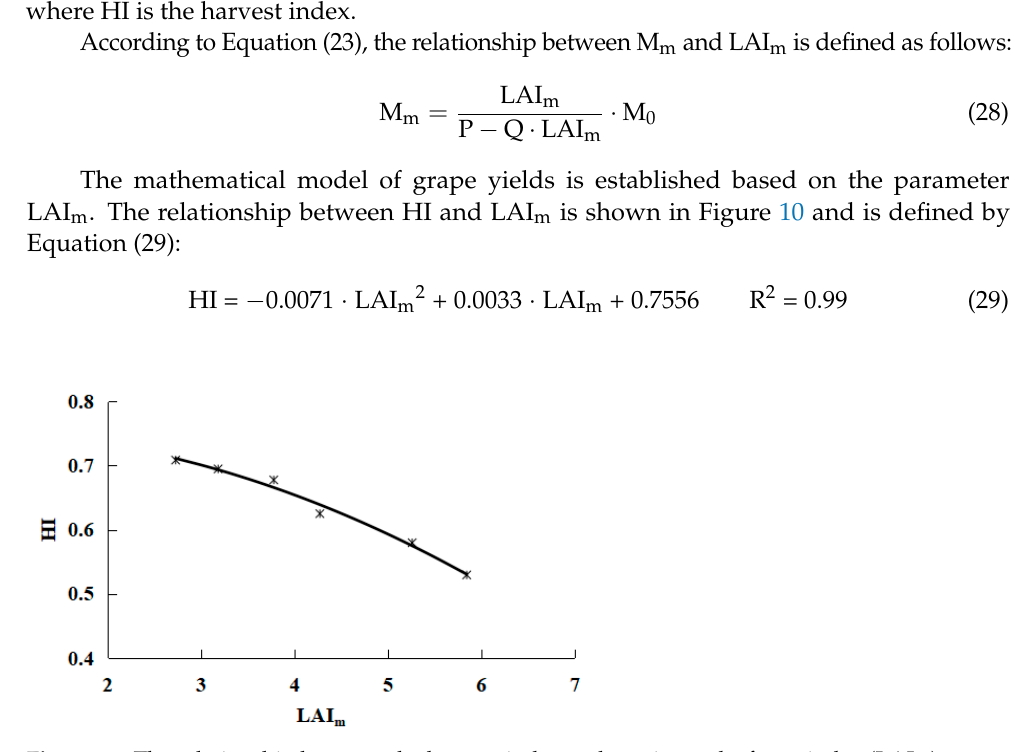
Figure 10. The relationship between the harvest index and maximum leaf area index (LAI m